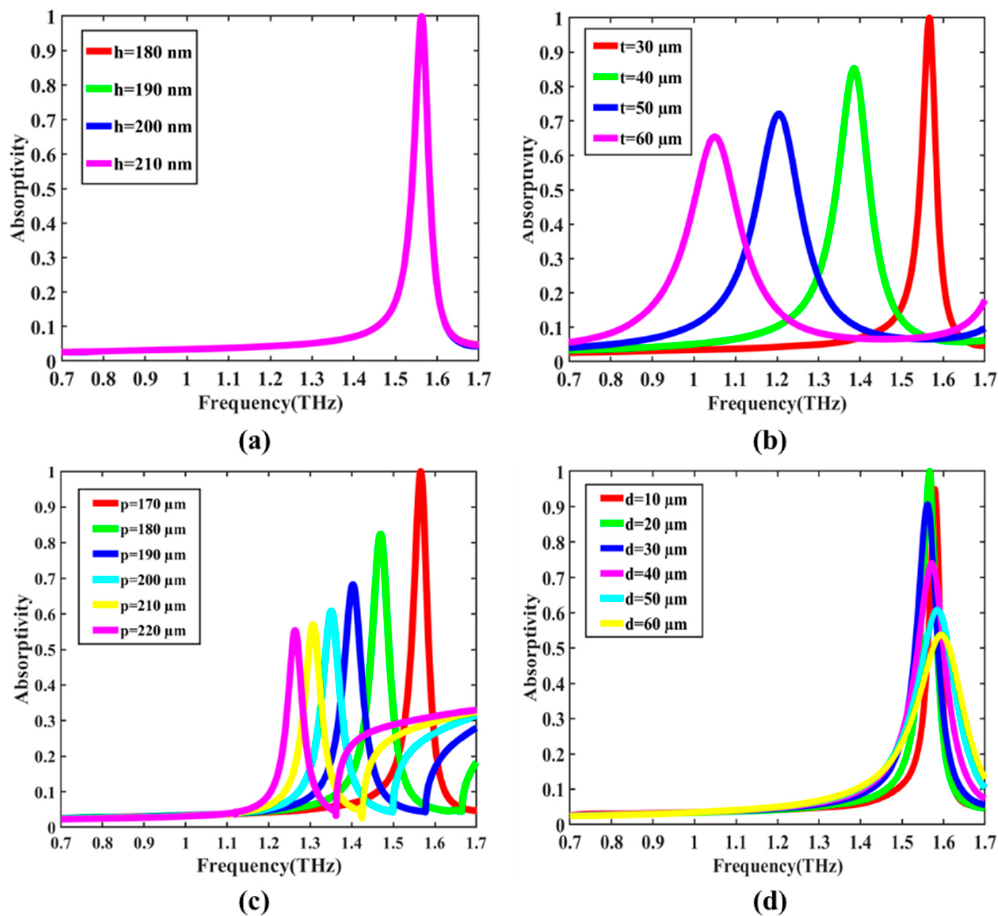
Figure 3. Absorption spectra of stainless steel terahertz absorbers in four different cases. ( a ) For four different substrate thickness values h. ( b ) For four different metal metamaterial layer thickness values t. ( c ) For six different period lengths p. ( d ) For six different radius differences d.